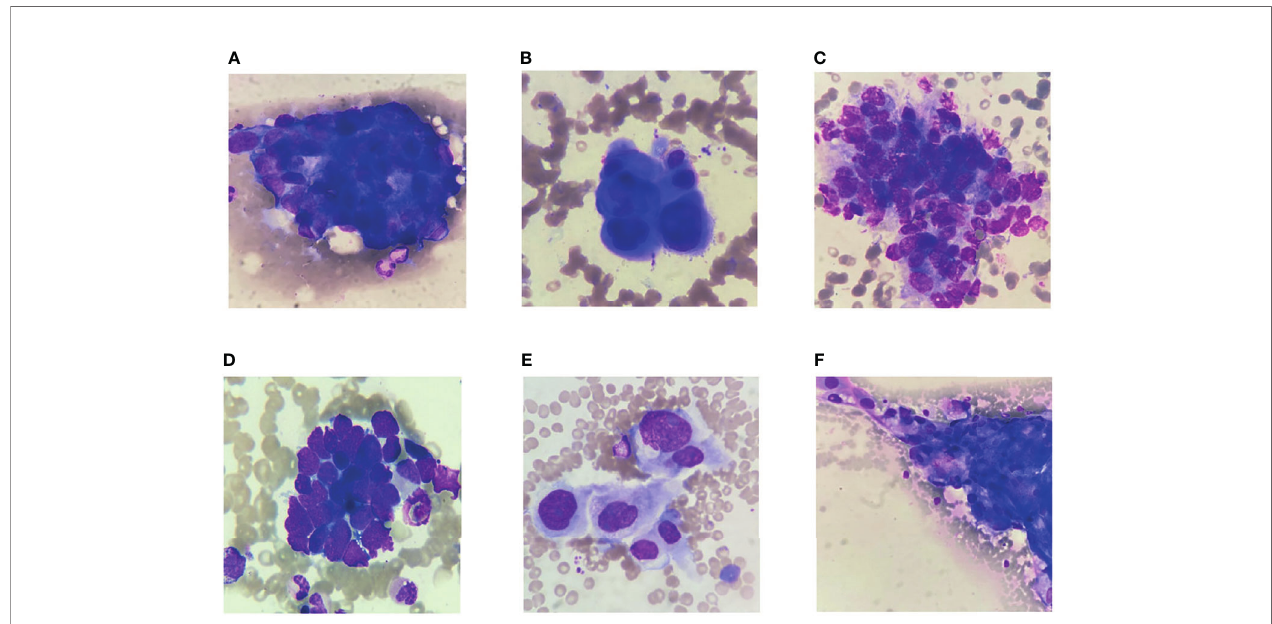
FIGURE 3 | Selected representative images of bone marrow smears extracted from digital histopathological microscopic scans. (A) Gastric carcinoma. (B) Breast carcinoma. (C) Prostate carcinoma. (D) Lung small cell carcinoma. (E) Cholangiocarcinoma. (F) Lung